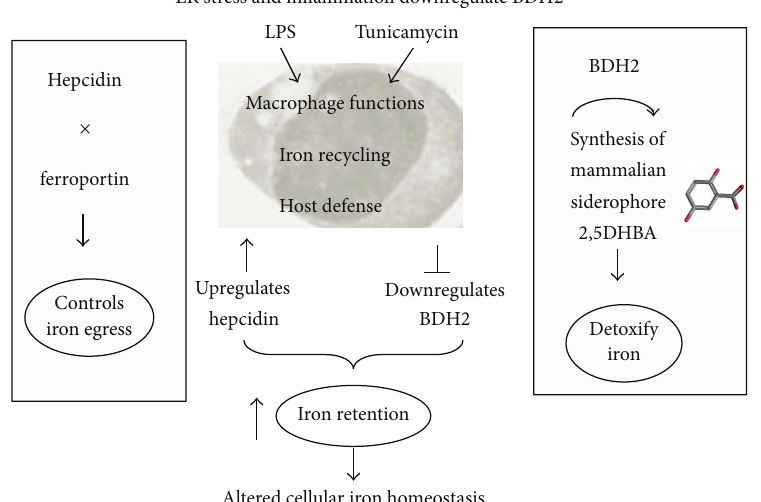
Figure 9: Schematic presentation of BDH2 downregulation in macrophages. BDH2 is the rate-limiting enzyme in the synthesis of the mammalian siderophore 2,5DHBA that detoxifies and traffics intracellular labile iron. Treatment of THP-1 macrophage-like monocytes with LPS or tunicamycin downregulates BDH2 expression leading to intracellular labile iron accumulation. Hepcidin is the master iron regulating hormone that binds to the only iron exporter ferroportin causing its internalization and degradation consequently preventing iron egress from macrophages. LPS and tunicamycin treatment increases hepcidin expression and downregulates ferroportin causing iron retention in macrophages. The downregulation of BDH2 contributes to altered cellular iron